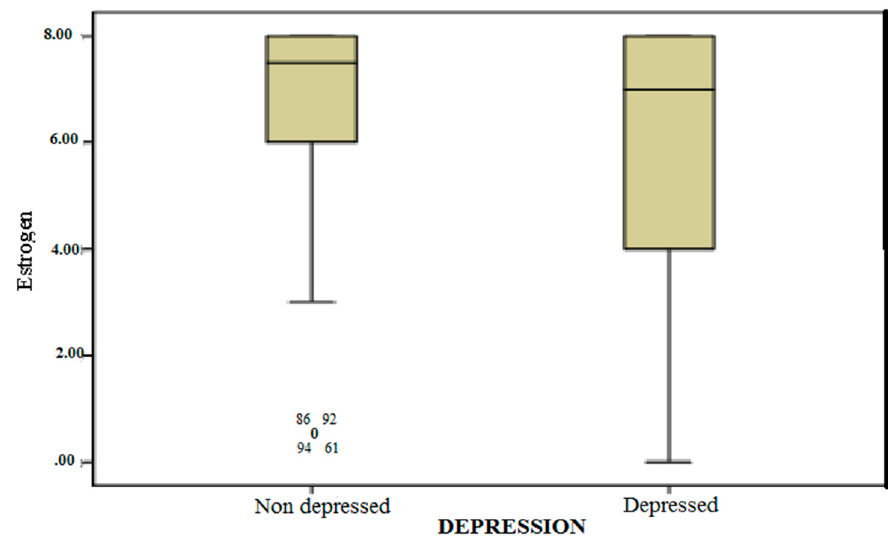
Figure 6. Correlation between level of depression and estrogen.